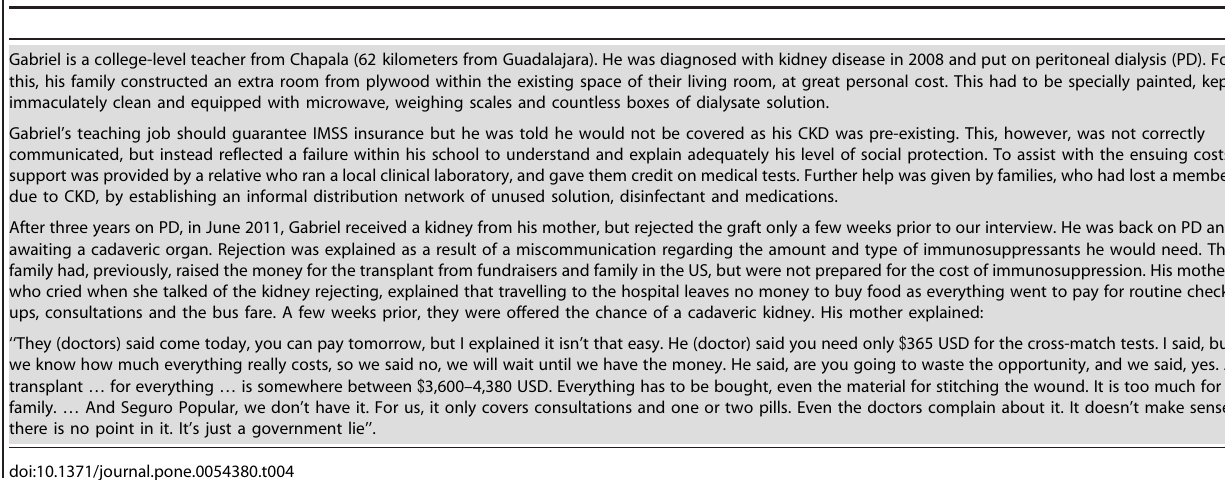
Table 4. Gabriel and his mother